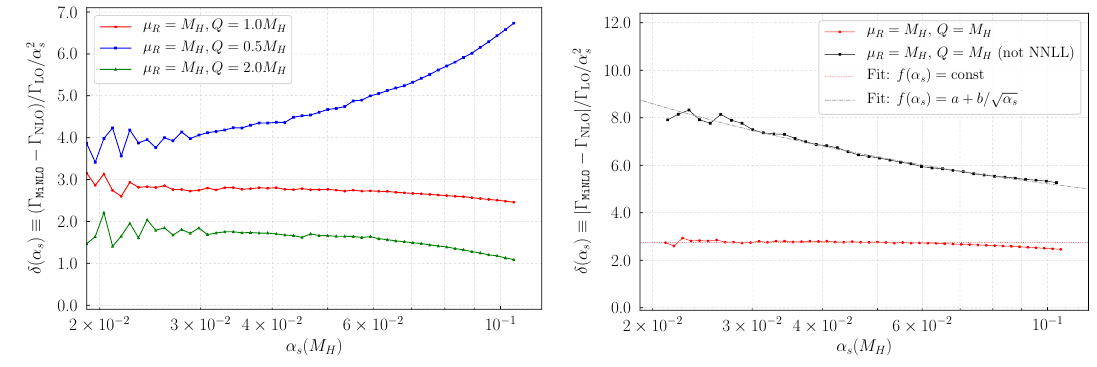
) s , shows that ( (cid:11) ) terms in s s O